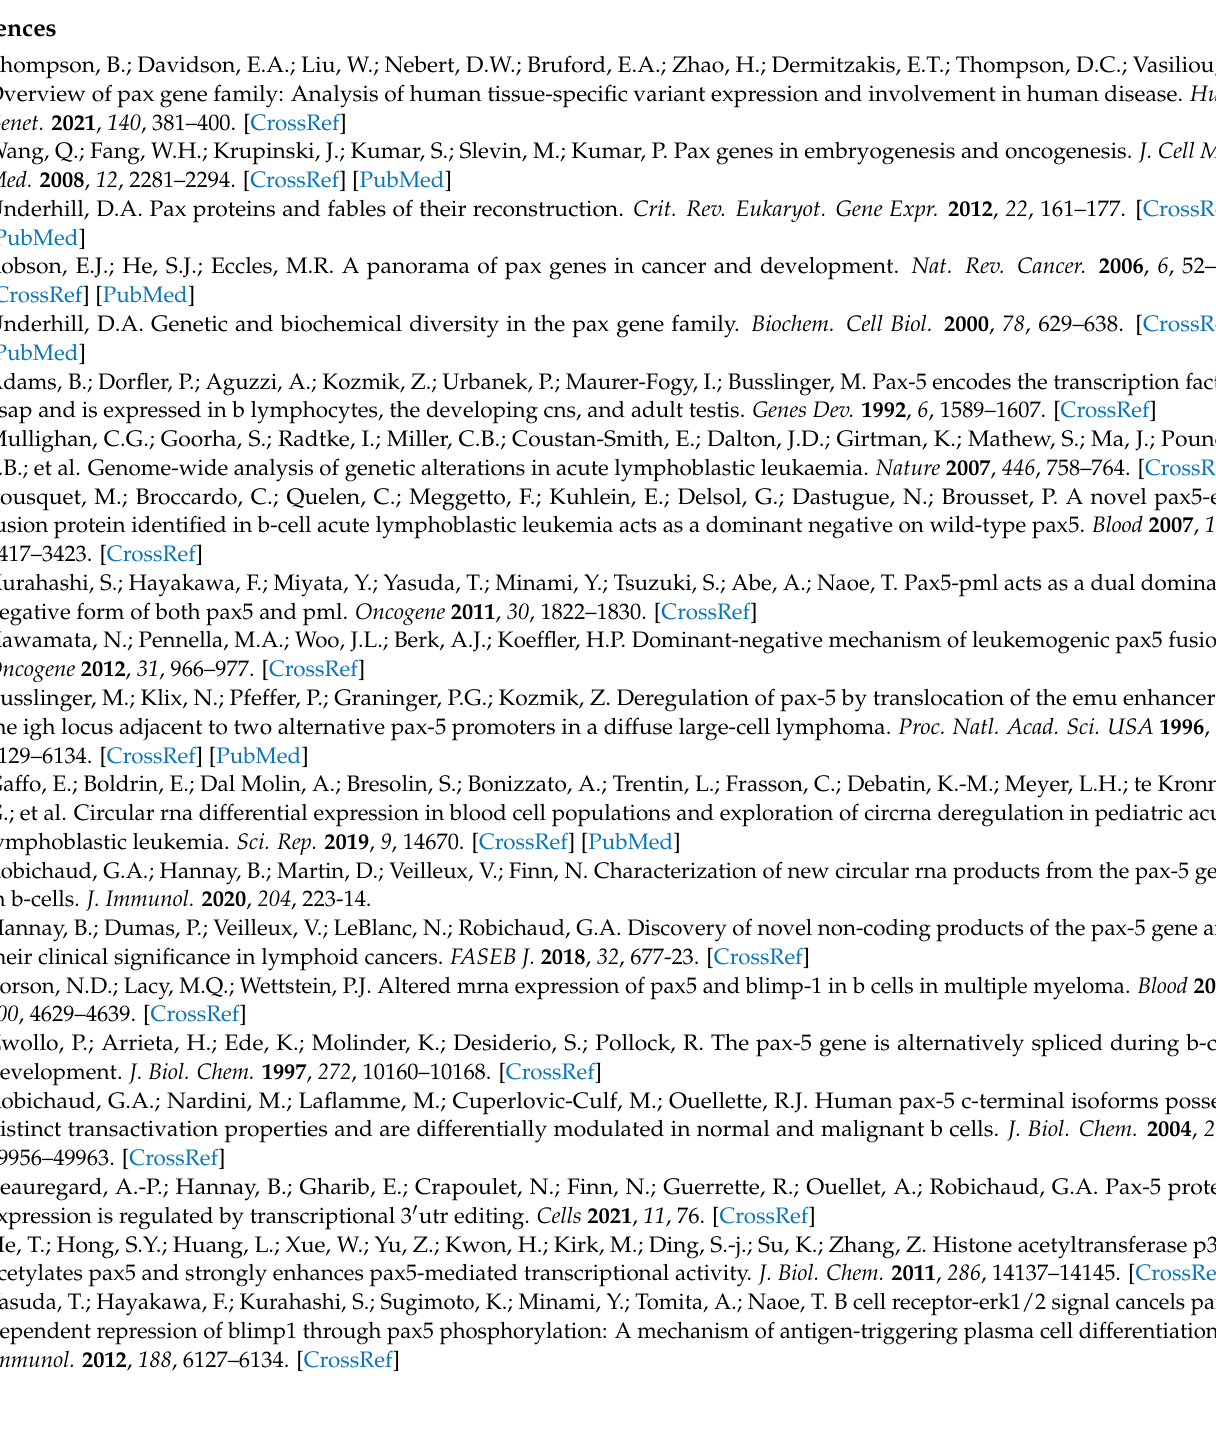
Data Availability Statement: The illustrated transcriptional data from Figure 2 was obtained from with the STAR algorithms (https://github.com/alexdobin/STAR, accessed on 1 April 2022). Data and comparison analysis of PAX5 protein levels were obtained from the Proteomics DB web tool Figure 3 was obtained from the Cytoscape plugin GeneMANIA (https://genemania.org, accessed on 8 April 2022). Schematic illustrations of functional annotations and biological terms visualization were done using the Enrichr algorithms (https://maayanlab.cloud/Enrichr, accessed on 10 April 2022). Conflicts of Interest: The authors declare no conflict of